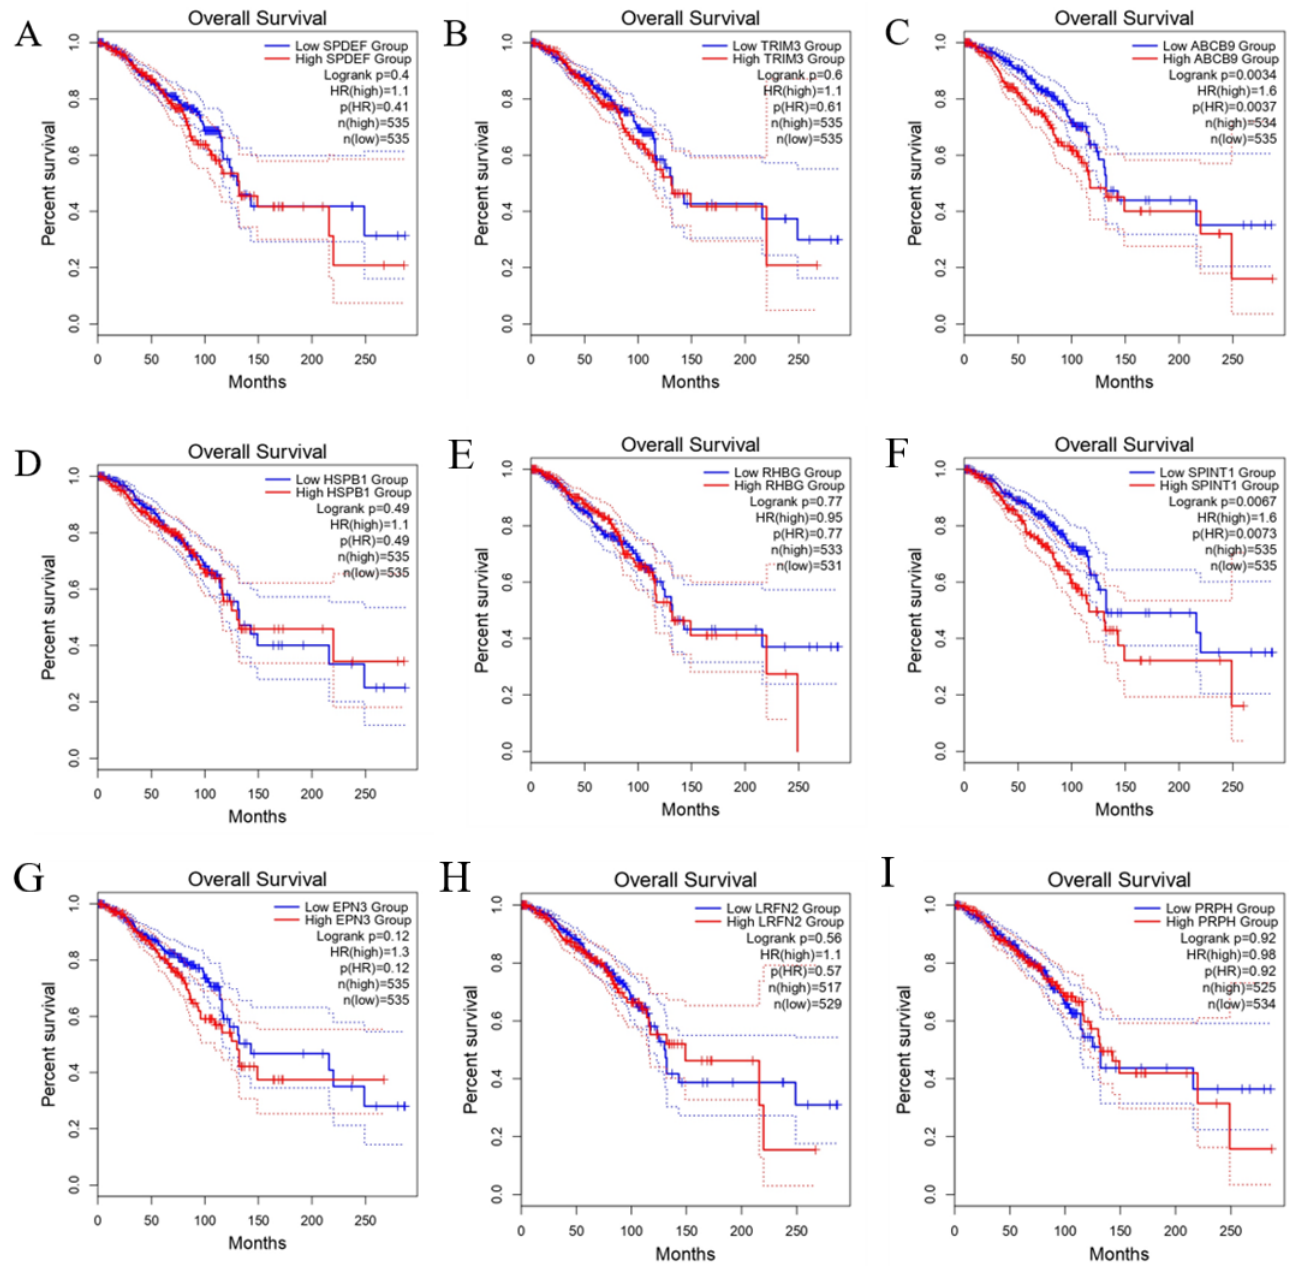
Figure 6. Overall survival (OS) validation of TCGA BRCA patients (GEPIA2). ( A ) SPDEF , ( B ) TRIM3 , ( C ) ABCB9 , ( D ) HSPB1 , ( E ) RHBG , ( F ) SPINT1 , ( G ) EPN3 , ( H ) LRFN2 , and ( I ) PRPH .